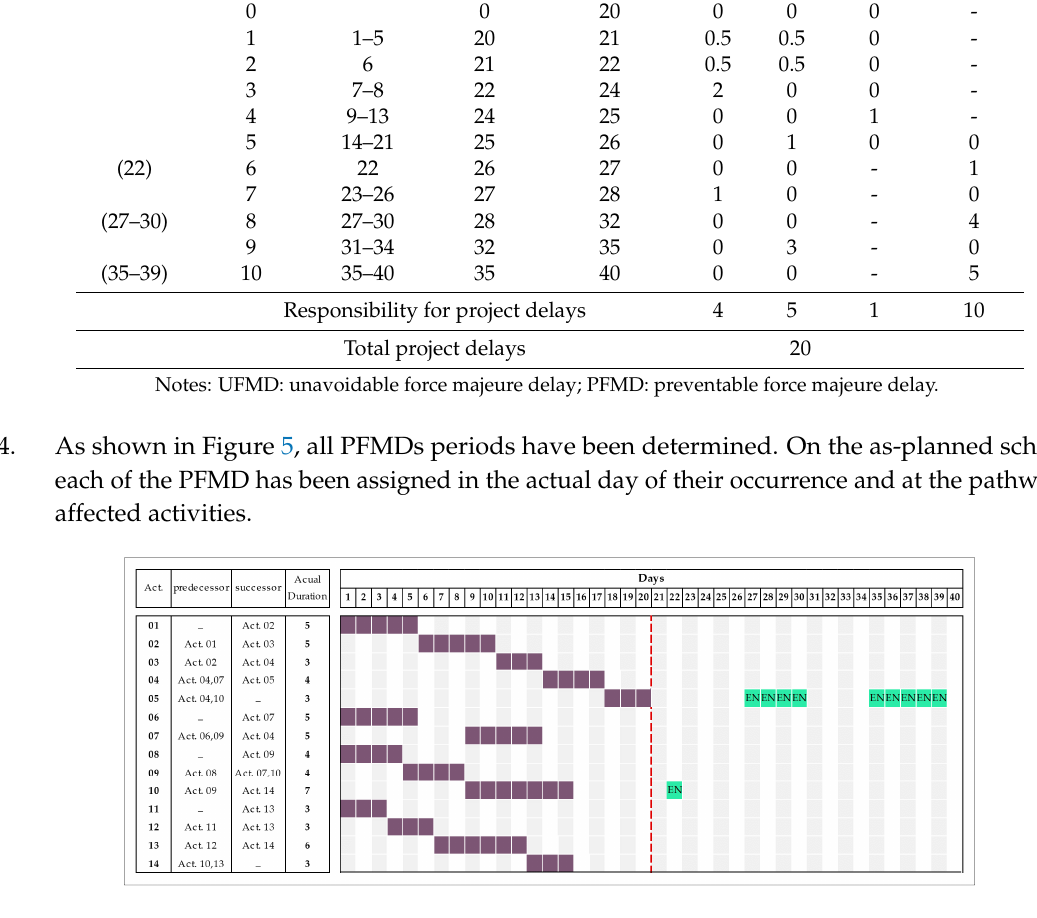
Figure 5. As-planned updated schedule.